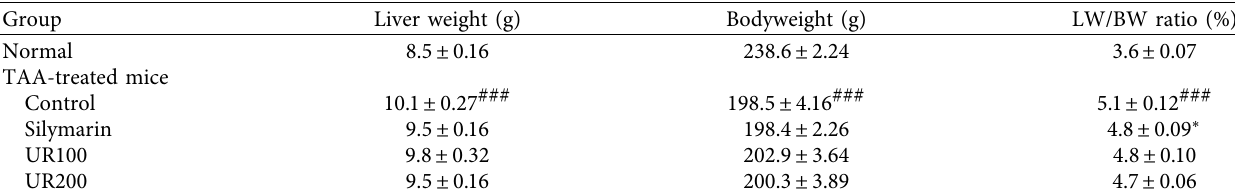
Table 1: The effect of UR on the liver weight, bodyweight, and LW/BW ratio. Group Liver weight (g)